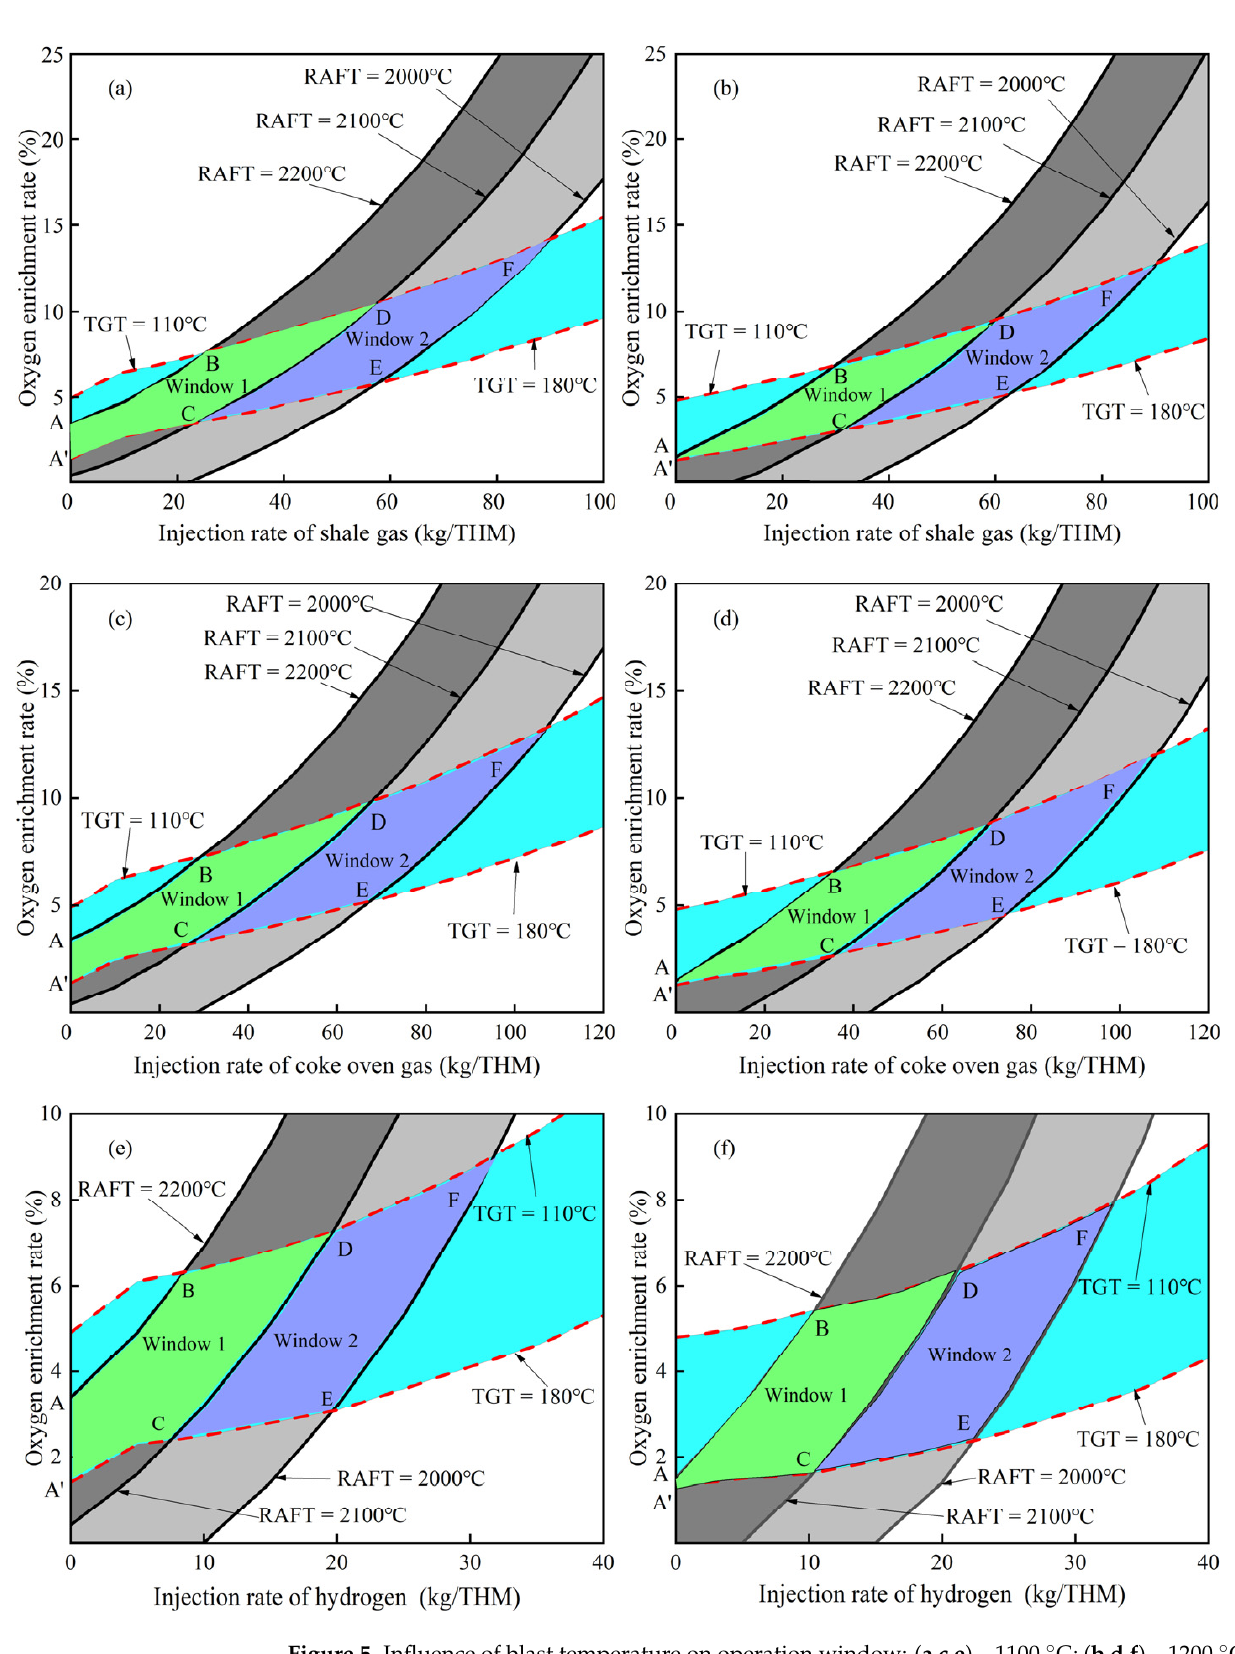
Figure 5. Influence of blast temperature on operation window: ( a , c , e )—1100 °C; ( b , d , f )—1200 °C.